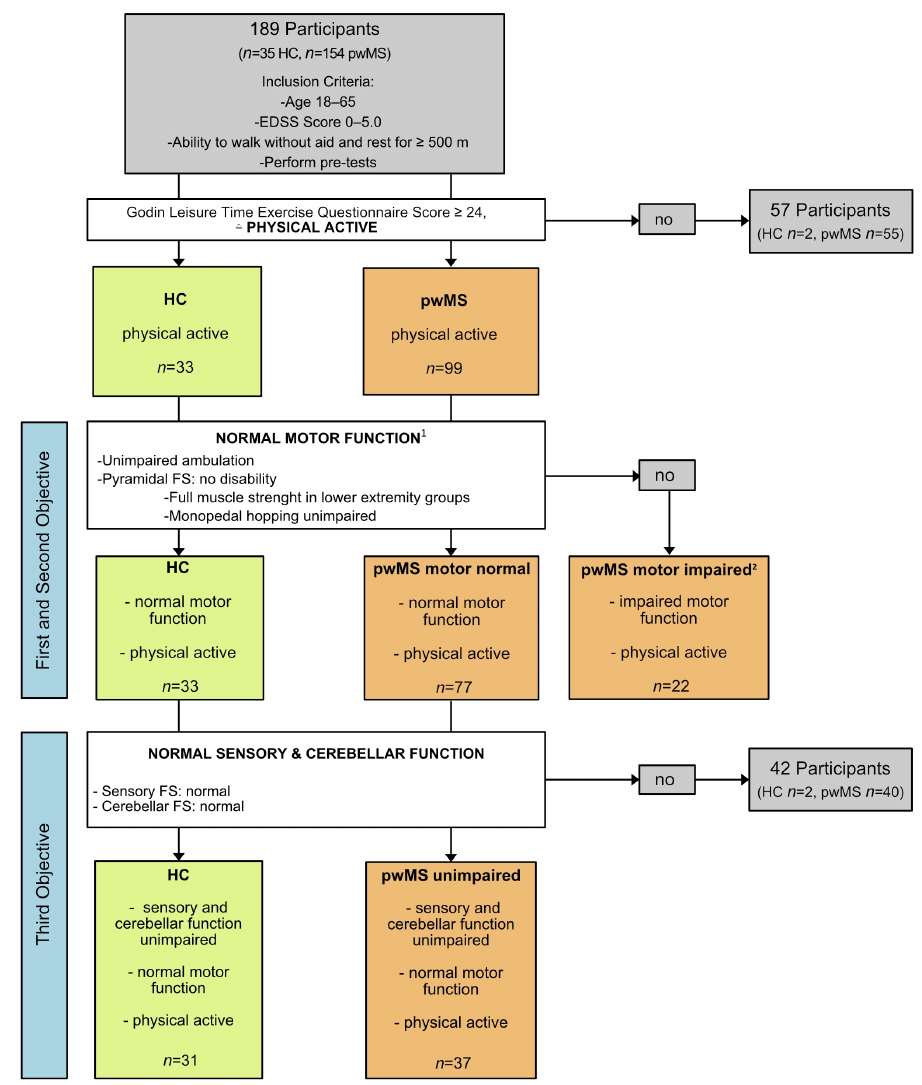
Figure 2. Flowchart of the study population. In order to create the best possible basis for comparability between groups, only participants with a GLTEQ ≥ 24, i.e., physically active, were included in the analysis. In a next adjustment step, the group of pwMS was divided according to the degree of disability and motor impairment assessed with EDSS. This resulted in a pwMS group with motor disability (pwMS motor impaired ) and a pwMS group without motor disability (pwMS motor normal ). PwMS motor normal thus corresponds to the HC group (all participants were examined with EDSS). In this study, the jumping performances between these three groups were analysed in two steps (first and second objective). Because sensory and cerebellar dysfunction can influence motor function, only participants without sensory and cerebellar dysfunction according to the EDSS were included in a finally analysis step (tertiary objective). 1 Normal motor function: EDSS score ≤ 1.5 with pyramidal FSS ≤ 1. 2 PwMS motor impaired: EDSS score ≥ 2 with pyramidal FSS of 2–4, reduced muscle strength and impaired monopedal hopping. Abbreviation: EDSS = Expanded Disability Status Scale; GLTEQ = Godin Leisure Time Exercise Questionnaire; FSS = functional system score; pwMS = people with multiple sclerosis; HC = healthy controls.